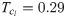
The effect of taking into account streamline dispersion on a set of extracted bundles: left iFOF, left CST, CC, and left fornix.(a) Conventional rendering in a sagittal, coronal, and axial view, respectively. (b) Global orientation-dependent transparency rendering (opacity axis coincides with the viewing axis with α
decreasing, c = 3, and n
scatter). (c) Global transparency rendering (same settings as in (b)) taking into account the dispersion of the streamlines (Tcl=0.29). White squares highlight streamlines that are rendered transparent when not taking into account streamline dispersion, but are visible when applying a c
l threshold.